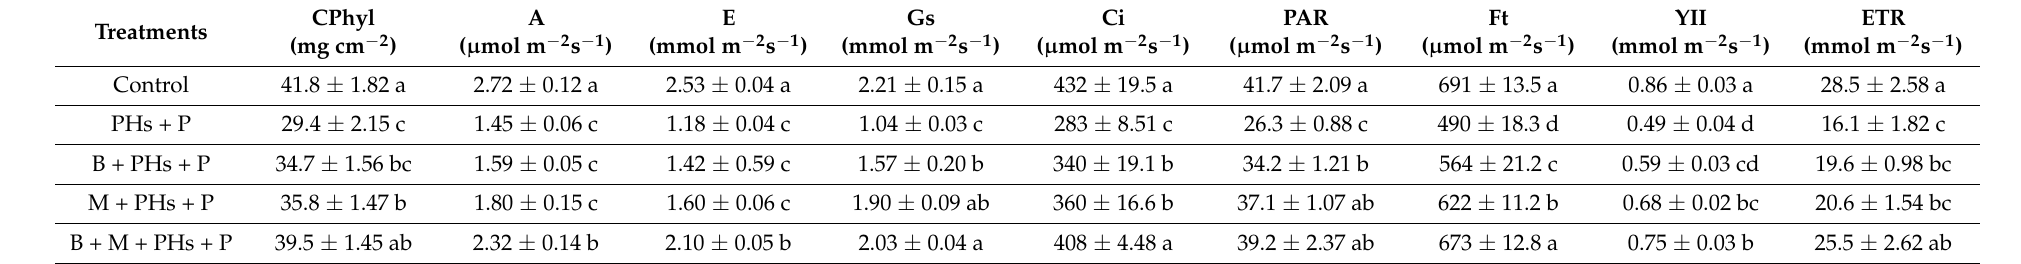
Table 3. Effect of biochar and Bacillus sp. MN54 on physiological attributes of maize plants grown in diesel contaminated soil.